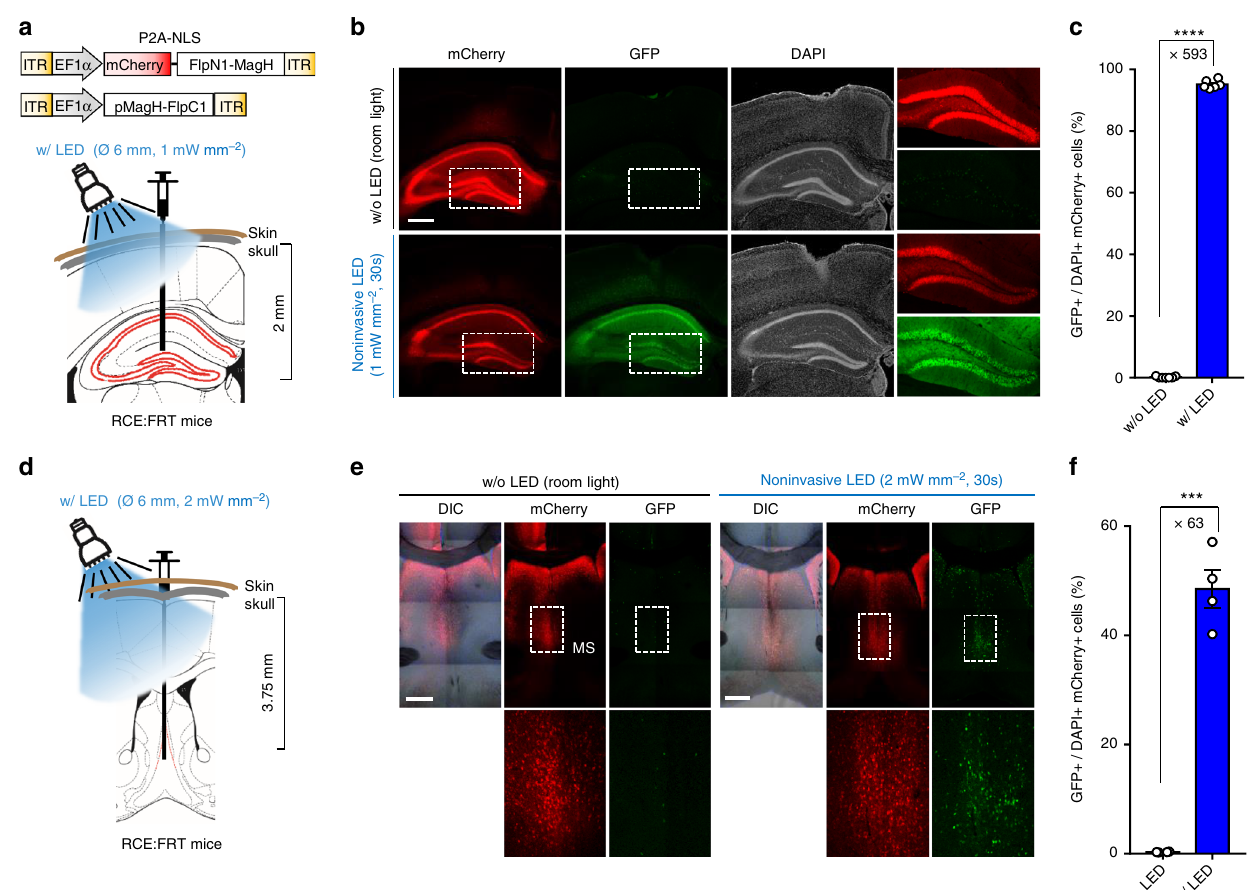
Fig. 2 Noninvasive LED illumination activates PA-Flp in deep brain structures down to the hippocampus and MS. a , d Schematic depicting AAV-EF1a-PA- Flp targeting in the hippocampus ( a ) or MS ( d ) followed by LED illumination. b , e Representative images of mCherry (PA-Flp) and GFP (Flp reporter) signals from RCE:FRT mice (8 – 12-wk-old), with (w/) and without (w/o) LED illumination. Two wks after infection, light was illuminated noninvasively with white LED at an intensity of 1 mWmm − 2 ( b ) or 2 mW mm − 2 ( e ) for 30 s through the intact skull and skin. Mice were maintained under room light as described in Methods. All mice were sacri fi ced 3 wks after infection. Scale bar: 500 μ m. c , f GFP positive cells among both DAPI and mCherry positive (GFP + /DAPI + mCh + ) cells were measured in the hippocampus ( c ) and MS ( f ) region of 4 – 7 coronal slices, as shown in b and e , respectively. Data represent means ± s.e.m. ( c , n = 4 mice/group, **** P < 1 × 10 − 10 ; f , n = 2 mice/group, *** P < 0.0001; two-tailed Student ’ s t